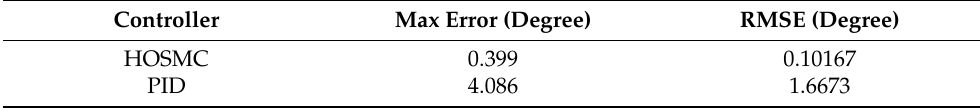
Table 12. Comparison table of robustness investigation between different robot arm controllers at a lower